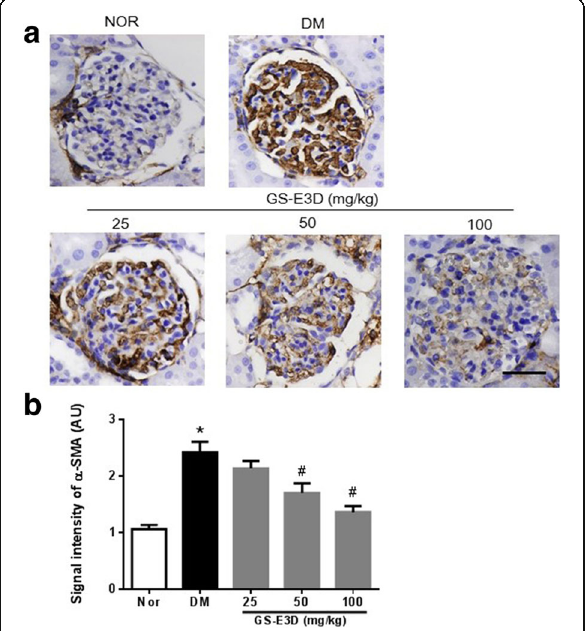
Fig. 4 The effect of GS-E3D on α -smooth muscle actin ( α -SMA) expression in glomeruli. ( a ) Immunohistochemical staining for α -SMA. Scale bar equals 50 μ m. ( b ) Quantification of the α -SMA signal intensity. NOR, normal rat; DM, streptozotocin-induced diabetic rat; GS-E3D, DM treated with the indicated dose of GS-E3D. All data were expressed as mean ± the standard error of the mean ( n = 8); * p < 0.05 vs. NOR group; # p < 0.05 vs. DM